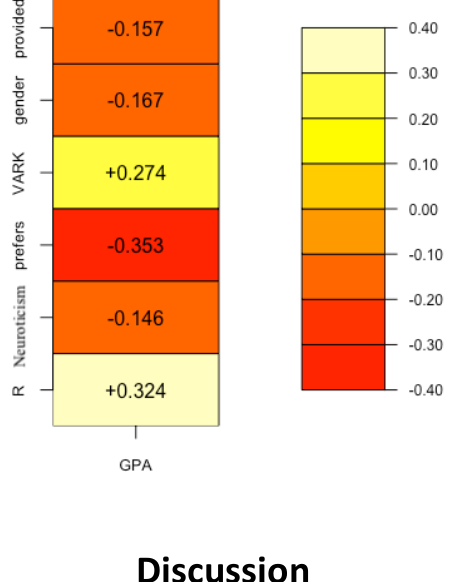
Figure 3 Correlation of Significance Codes for Overall Academic